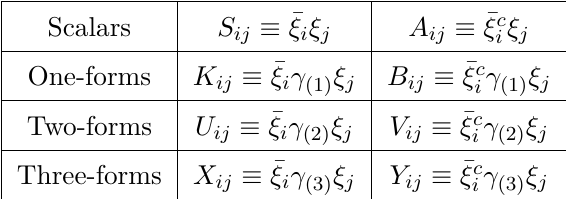
Table 1 . Definition of the spinor